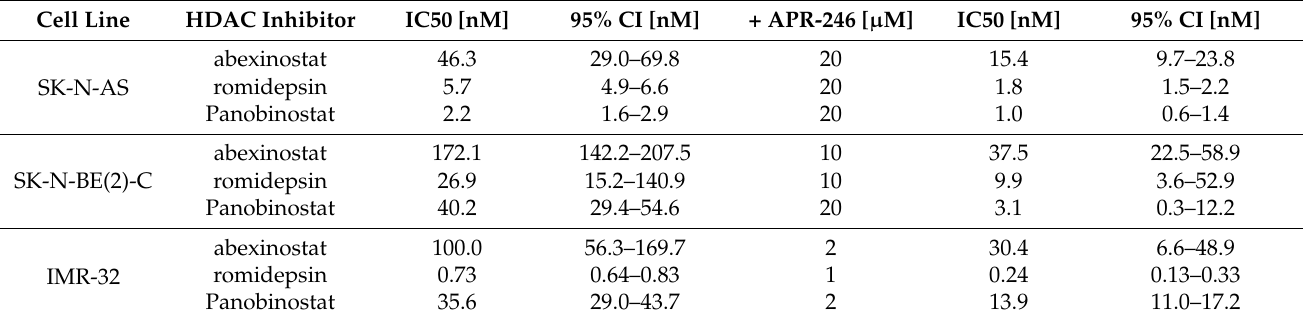
Table 5. HDACi screening for abexinostat, romidepsin and Panobinostat in three neuroblastoma cell line models. Cell